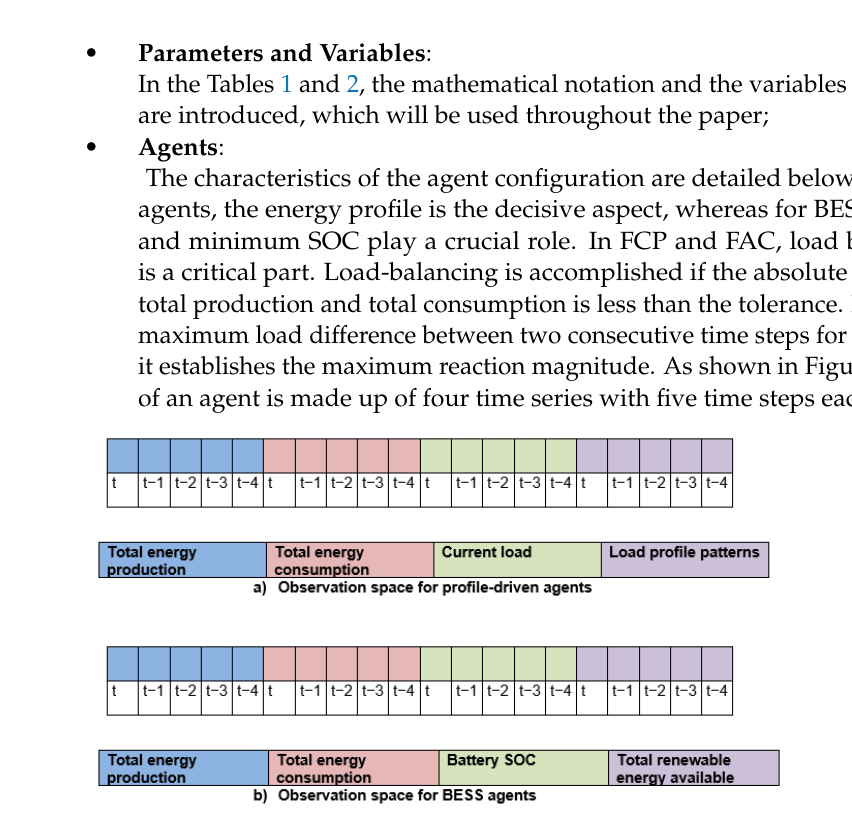
Figure 3. Observation space for agents.